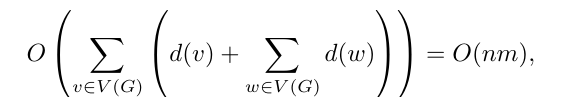
Fig. 3: A perfect disimplicial elimination digraph with a non-perfect maximal disimplicial elimination: v → w and v → z 1 , z 2 → z 3 , z 4 → z 5 , z 6 → w are maximal disimplicial eliminations. is,